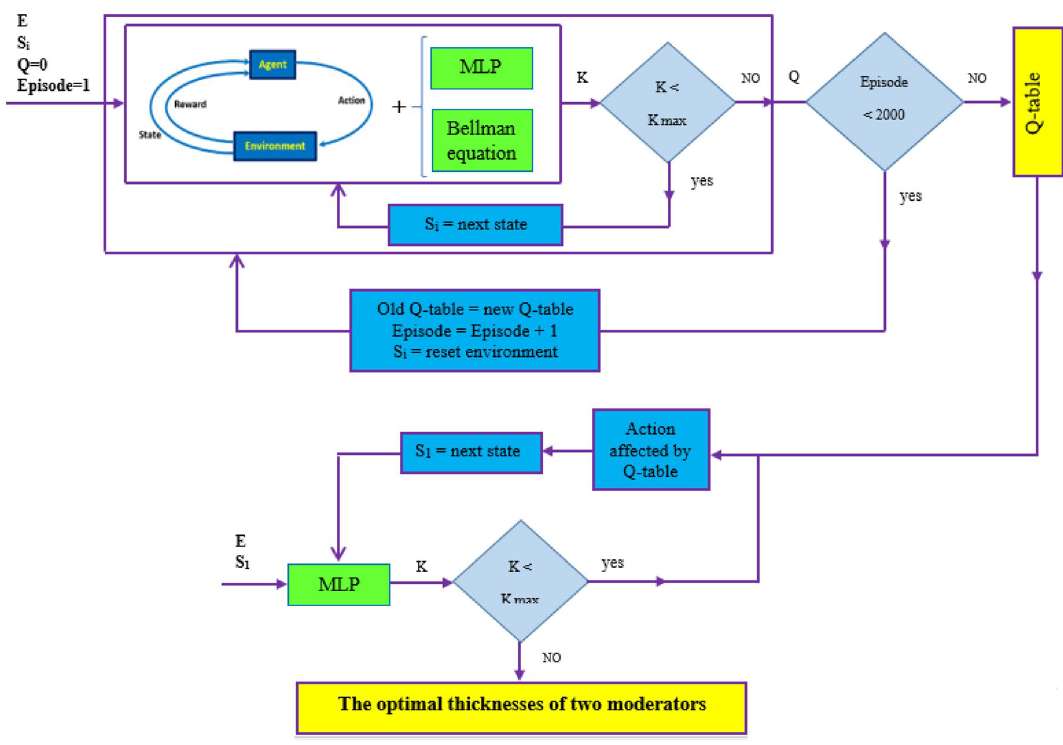
Figure 11. The flowchart of the performance of our hybrid Q-learning algorithm + the MLP neural network to obtain the optimal thickness values of the two moderators.